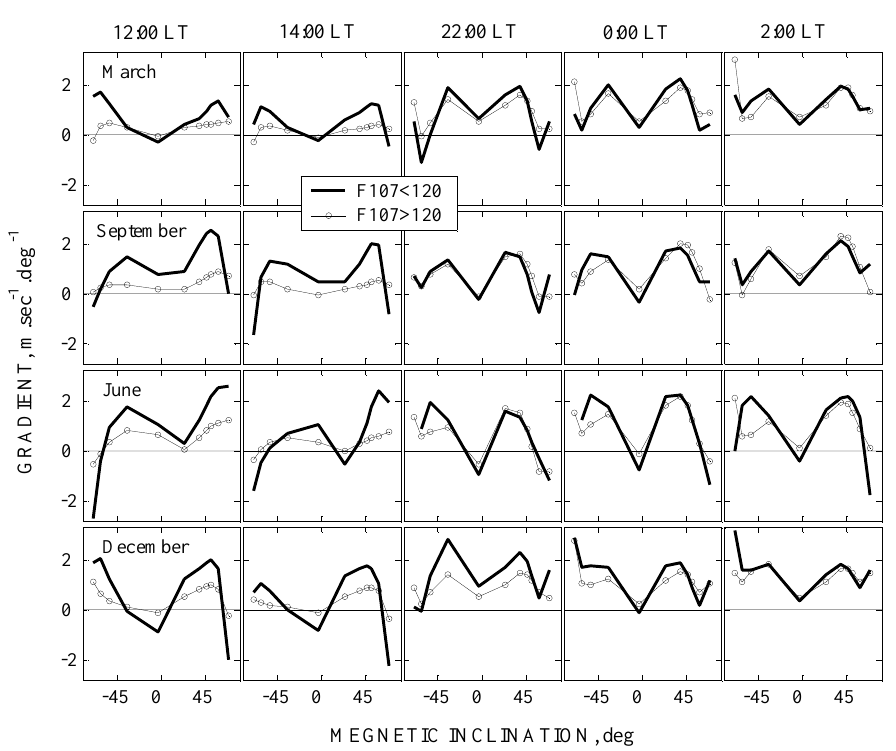
Fig. 5. The magnetic latitudinal gradient of the VEWs near noon and midnight hours for all seasons at solar minimum and solar maximum. very significant latitudinal gradients for meridional winds at also appear at higher mid-latitudes during summer solstice all seasons, especially during equinox periods at solar min- periods near imum. The strong positive latitudinal gradients for VEWs and meridional winds at southern higher mid-latitudes sug- vection (Hagan, 1993; Emmert et al., 2003). Strong gradients